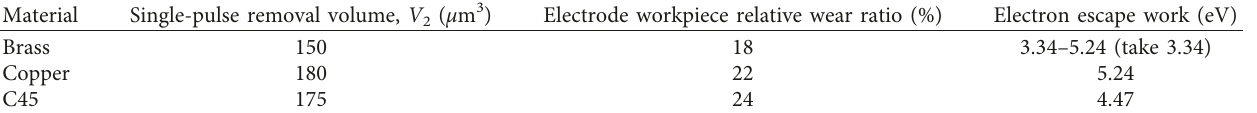
Table 3: Single-pulse removal volume and relative wear ratio of electrode materials.